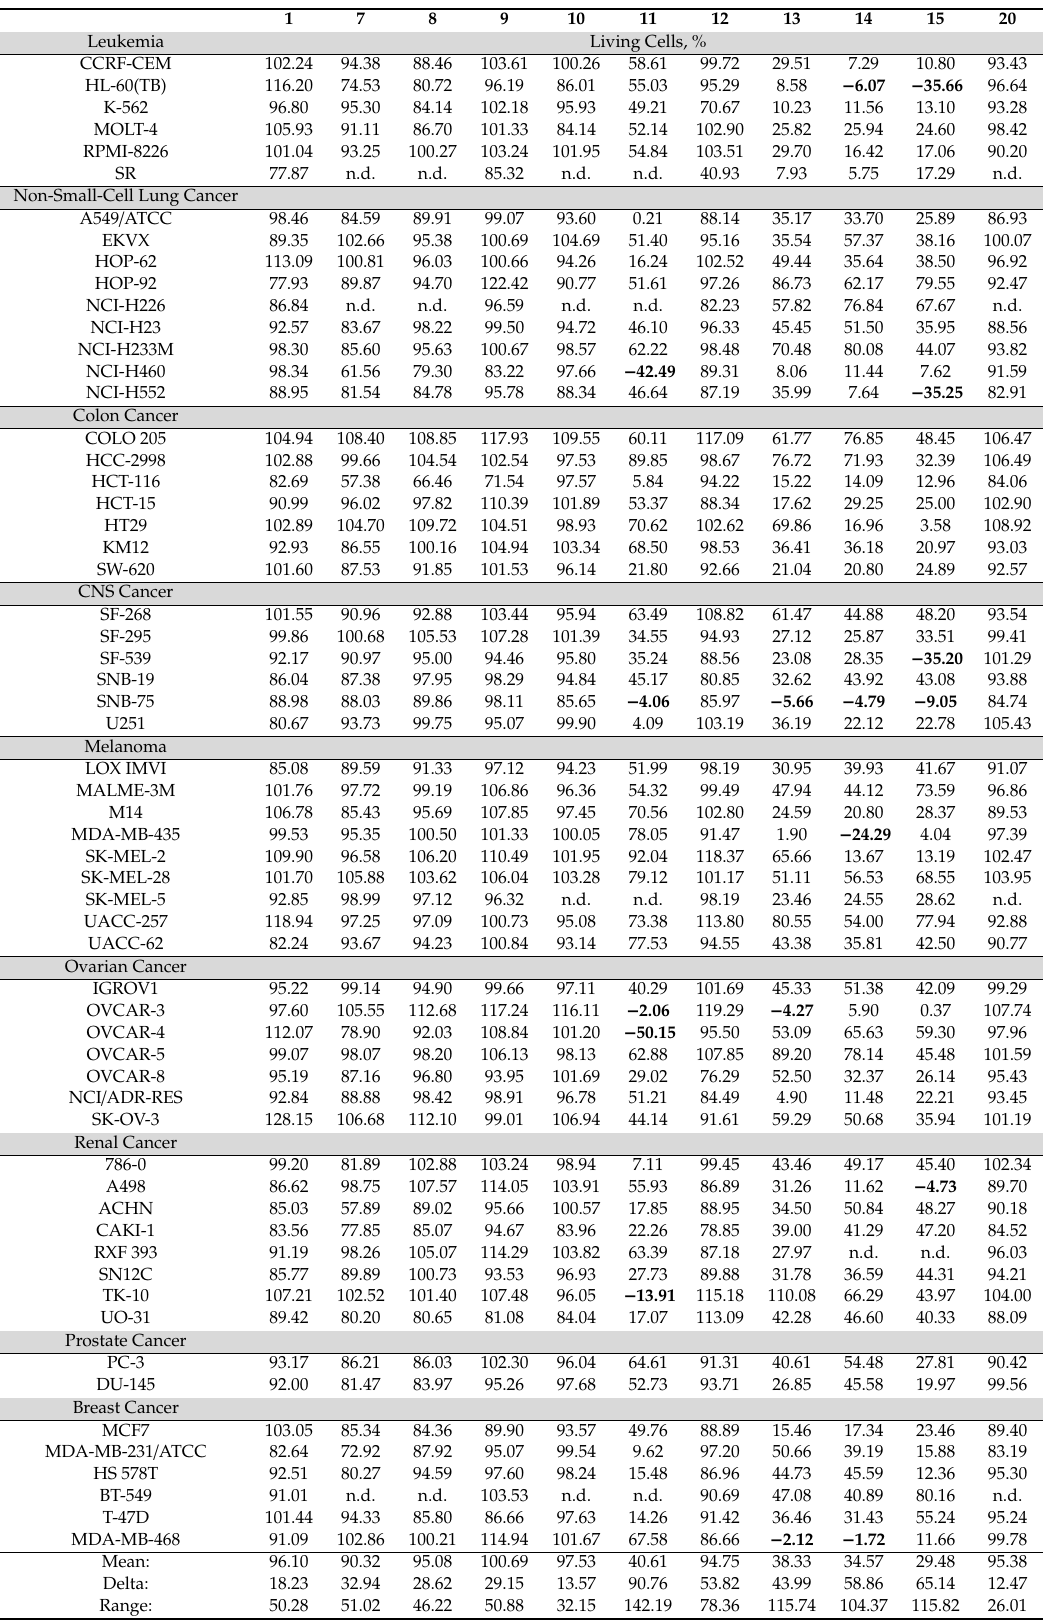
Table 3. Antiproliferative activities of chrysin ( 1 ) and compounds 7 – 15 and 20 against 60 human cancer cell lines in vitro. The negative numbers causing cell death are highlighted in